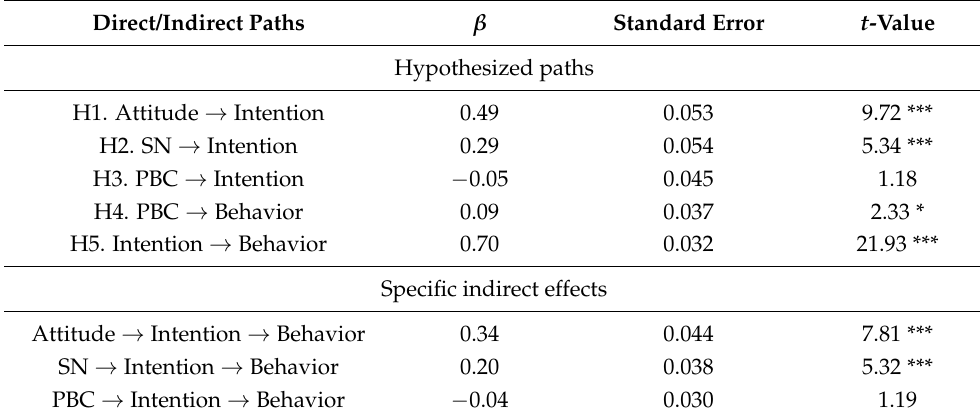
Table 2. Results of the hypothesized